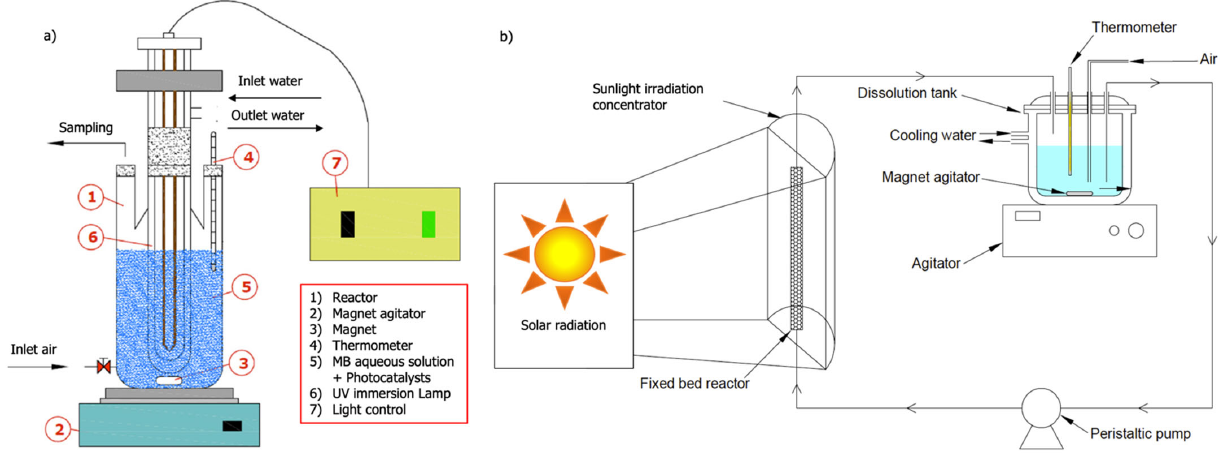
Figure 2. Schema of photoreactors. ( a ) Batch photoreactor; ( b ) fixed bed photoreactor.